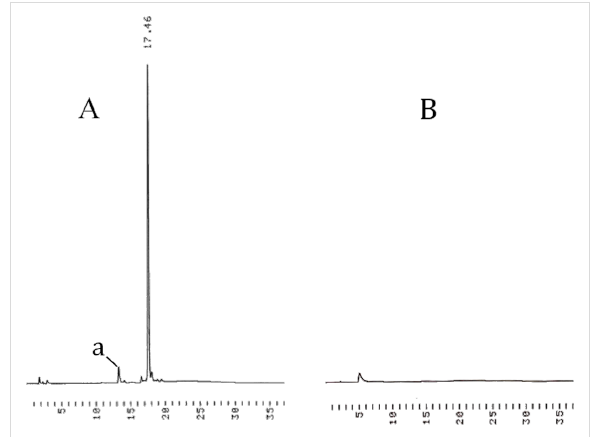
Figure 2: HPLC traces referring to precipitation of the tetrapodal support bearing 5'- O -deprotected UU-dimers, i.e., after the deprotec- tion step: (A) stands for the precipitate and (B) for the filtrate after the precipitation. For the chromatographic conditions, see the legend of Figure